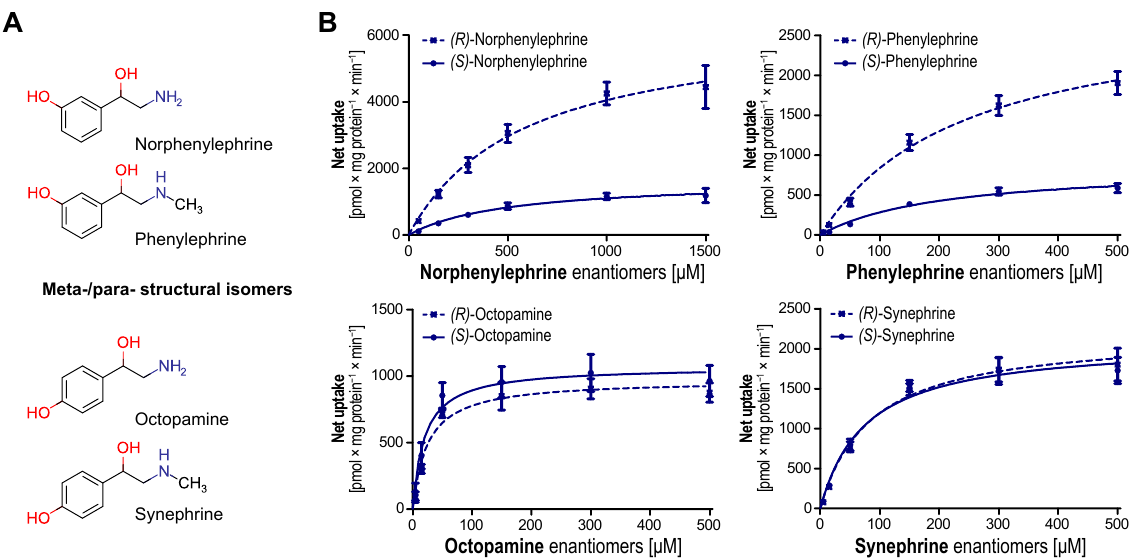
Figure 4. Chemical structures of single ring-hydroxylated phenylethylamine analogues ( A ). Stereoselective uptake analyses by OCT3 ( B ). Data is provided as mean ± SEM of three independent